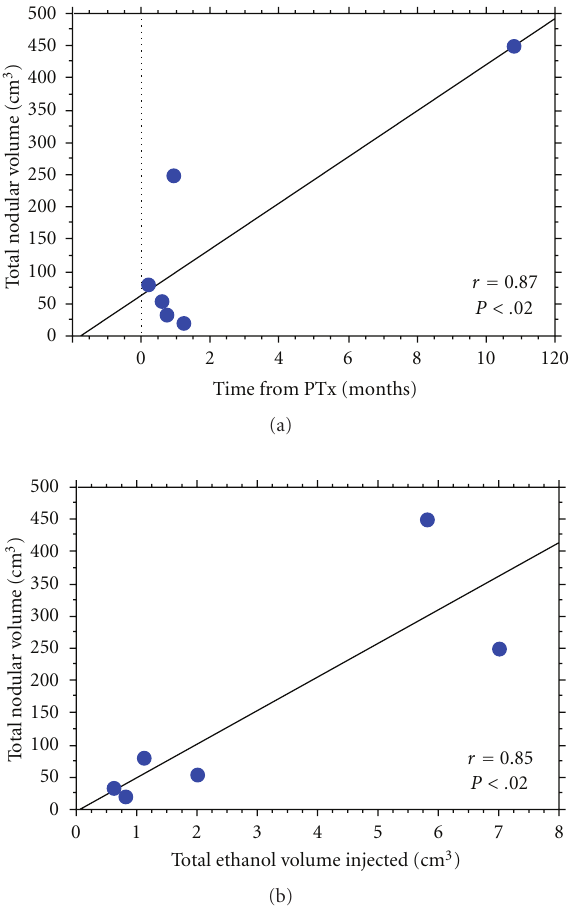
Figure 2: Correlation between total nodular volume, total volume of ethanol used, and the time from parathyroidectomy